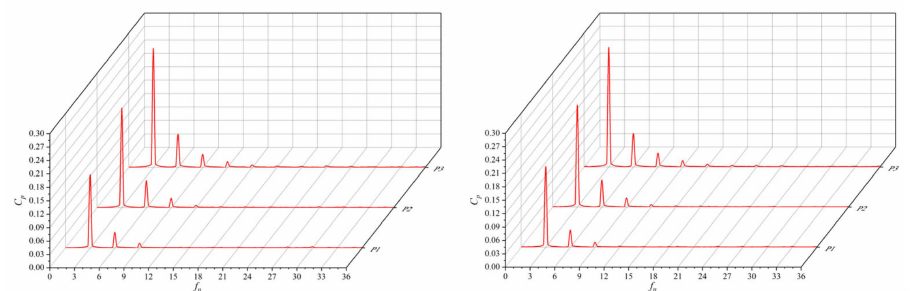
Figure 14. Frequency domain of pressure pulsation at impeller inlet ( Q = Q d ): ( a ) shaft front- positioned tubular pump device; ( b ) shaft rear-positioned tubular pump